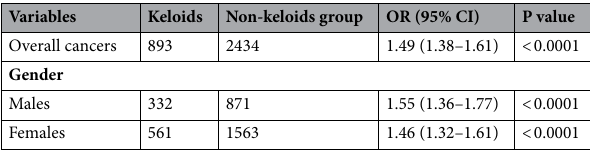
Table 2. Total cancer risk in patients with keloids, stratified by gender. OR odd ratio, 95% CI 95% confidence interval.